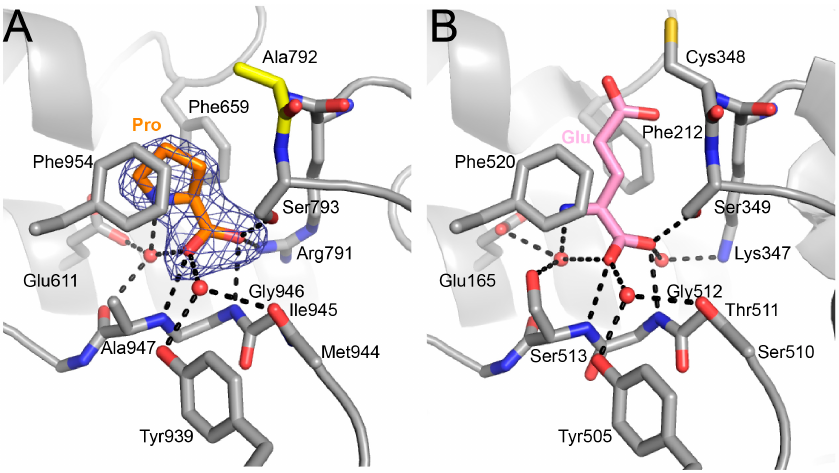
Figure 5. Proline inhibits the GSAL site of the GSALDH module. ( A ) Electron density and interactions for proline bound in the GSAL site. The mesh represents a simulated annealing F o – F c omit map contoured at 3.0 σ . ( B ) The active site of mouse GSALDH (ALDH4A1) complexed with the product glutamate (PDB ID 3V9K). Water molecules that mediate enzyme-ligand hydrogen bonds are represented by red spheres.